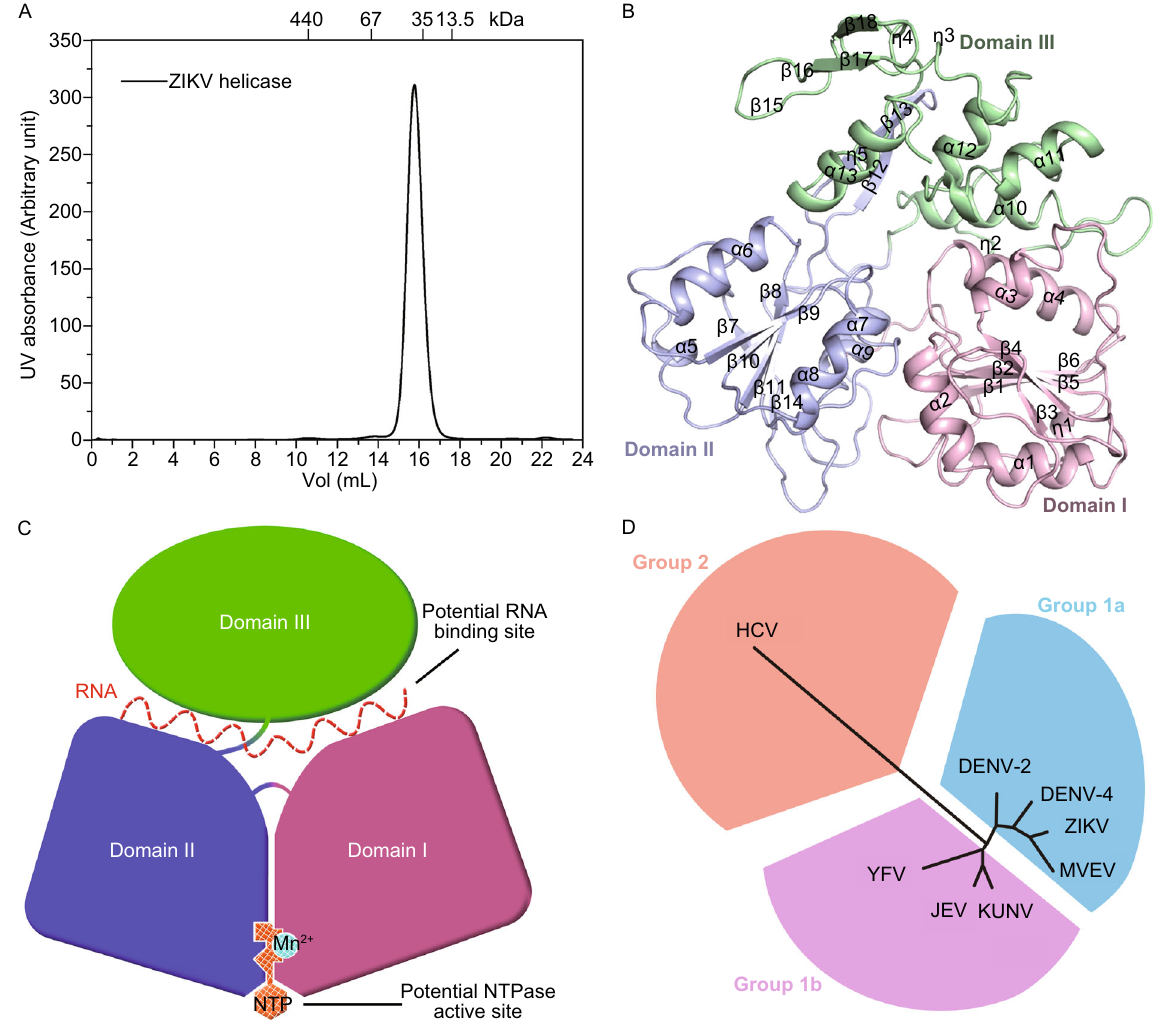
Fig. 1. The monomeric structure of ZIKV helicase . (A) Size-exclusion chromatograms of ZIKV helicase. The molecular masses of protein standards are indicated at the top. (B) The overall structure of ZIKV helicase with the three domains colored and labeled respectively. (C) A cartoon diagram illustrating of the overall fold with potential RNA binding site and NTPase active site labelled. (D) Structure-based phylogenetic tree of 8 viral helicase structures from the Flaviviradae family using the program SHP (Stuart et al., 1979) and PHYLIP (Felsenstein, 1997). The following structures with PDB ID in parentheses are included: DENV-2 (2BMF), DENV-4 (2JLQ), JEV (2Z83), KUNV (2QEQ), YFV (1YKS), MVEV (2V8O),